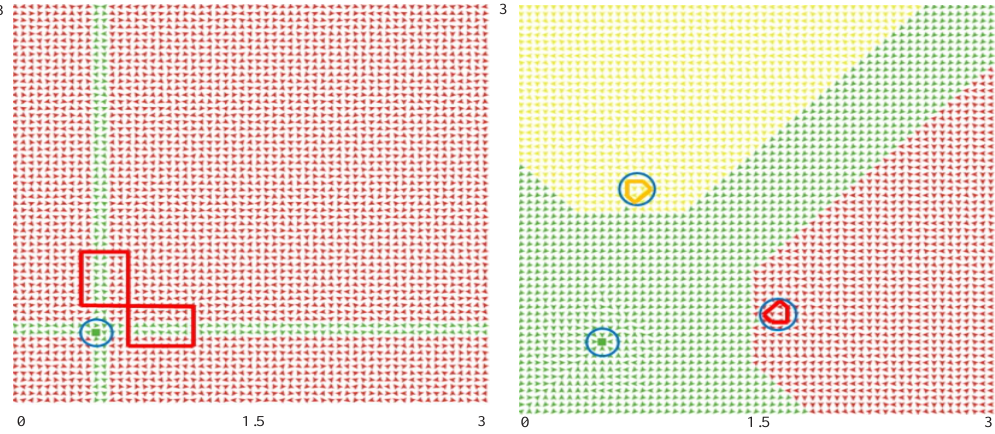
Figure 12. Domain of attraction: sequential move ( left ) and simultaneous move ( right ).